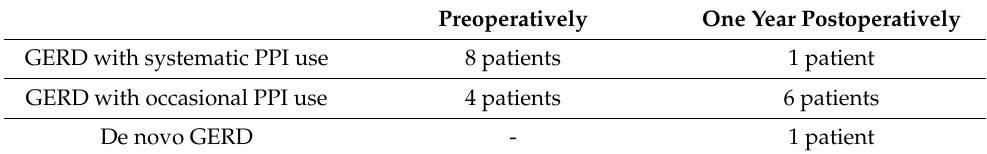
Table 1. GERD evolution and PPI